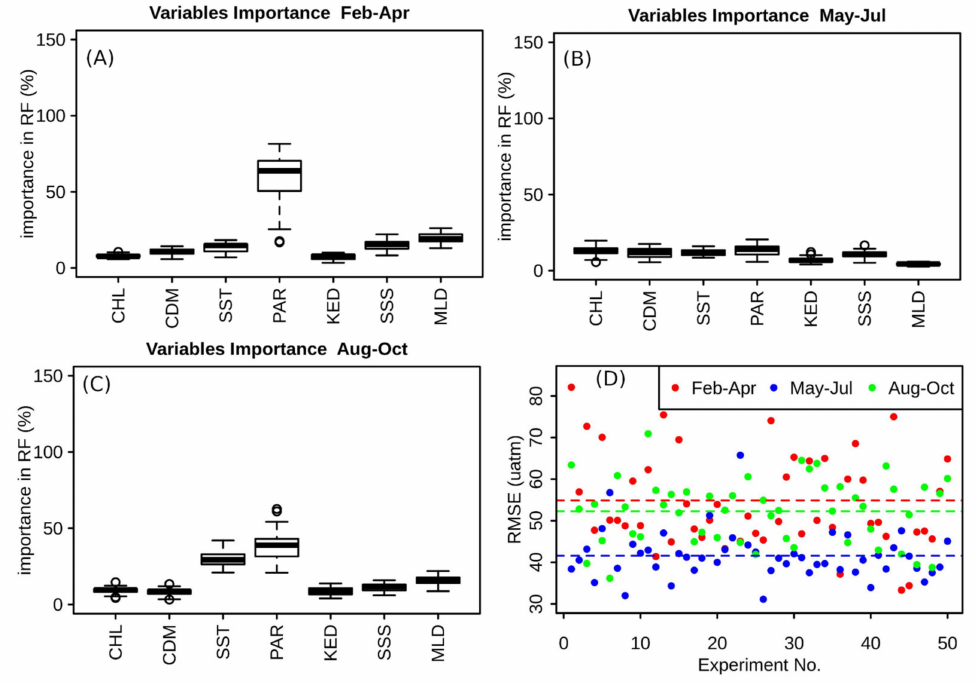
Figure 3. Variables’ importance for pCO 2 estimate in the entire Baltic Sea in different seasons ( A – C ) and the RMSEs of the corresponding 50 models ( D